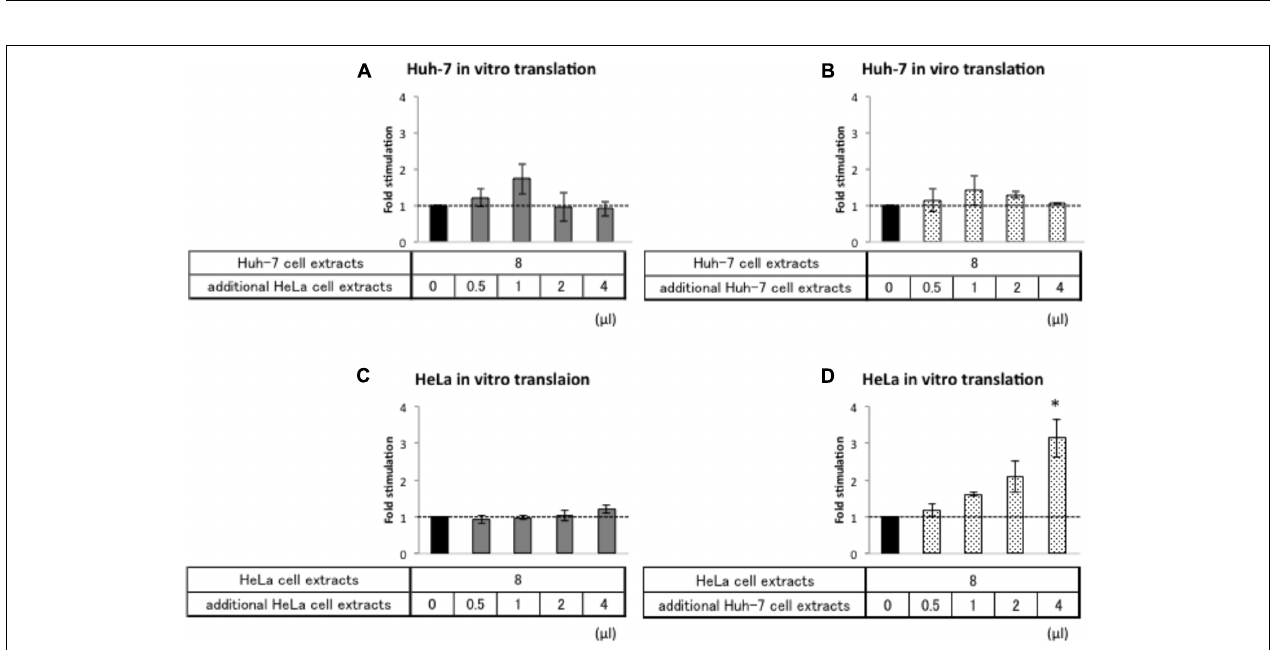
FIGURE 5 | Huh-7 cell extracts contain a factor that promotes HAV IRES-mediated translation. Huh-7-based (A,B) or HeLa-based (C,D) in vitro translation reaction were performed with Acap-HAV-IRES-Nluc-poly(A) reporter mRNA. In vitro translation reactions were carried out in the presence of additional cell extracts (gray bars: HeLa, dotted bars: Huh-7) or absence of them (black bar). Each bottom panel indicates the volume of additional cell extracts added. The total volume of reaction mixture was not changed. HAV IRES-mediated translation was normalized by cap-dependent translation. Fold stimulation by additional cell extracts was calculated by dividing relative light units of Acap-HAV-IRES-Nluc-poly(A) obtained in translational effector-added translation reactions by those in lysis buffer-added translation reactions, which are set as 1 (symbolized as dotted line). The mean values ± SD from three independent experiments are shown. The asterisk indicates statistically significant differences in additional HeLa cell extracts (C) or Huh-7 cell extracts (D) in HeLa-based in vitro translation system ( p < 0.05).